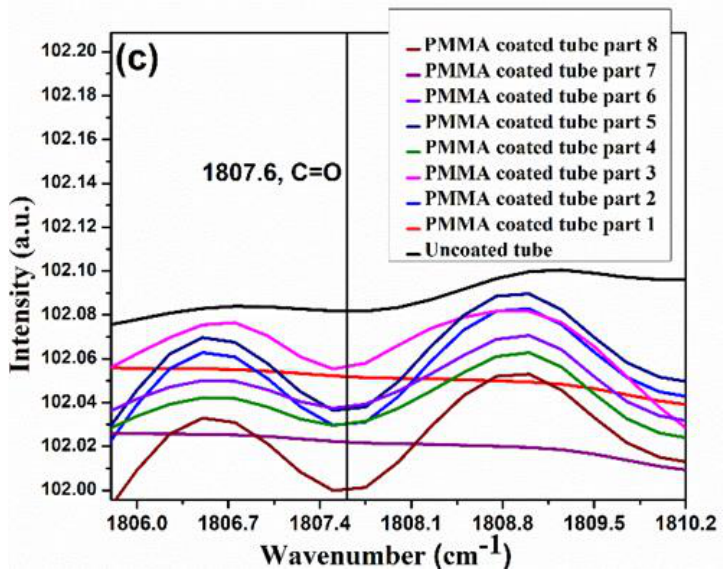
Figure 8. ATR – FTIR spectrum for PP-MMA coating inside the silicone tube corresponds to the 100 W (RF) plasma and 40 volume percentage of monomer. ( a ) The whole ATR-FTIR spectrum for PP- MMA-coated/-uncoated silicone tubes. ( b ) Band depiction of PP-MMA on the inner surface of the silicone tube in the range of 1460 to 1480 cm − 1 . ( c ) Band depiction of PP-MMA on the inner surface of the silicone tube in the range of 1800 to 1810 cm − 1 . The uncoated tube represents the condition in which there was no plasma initiation inside the tube.